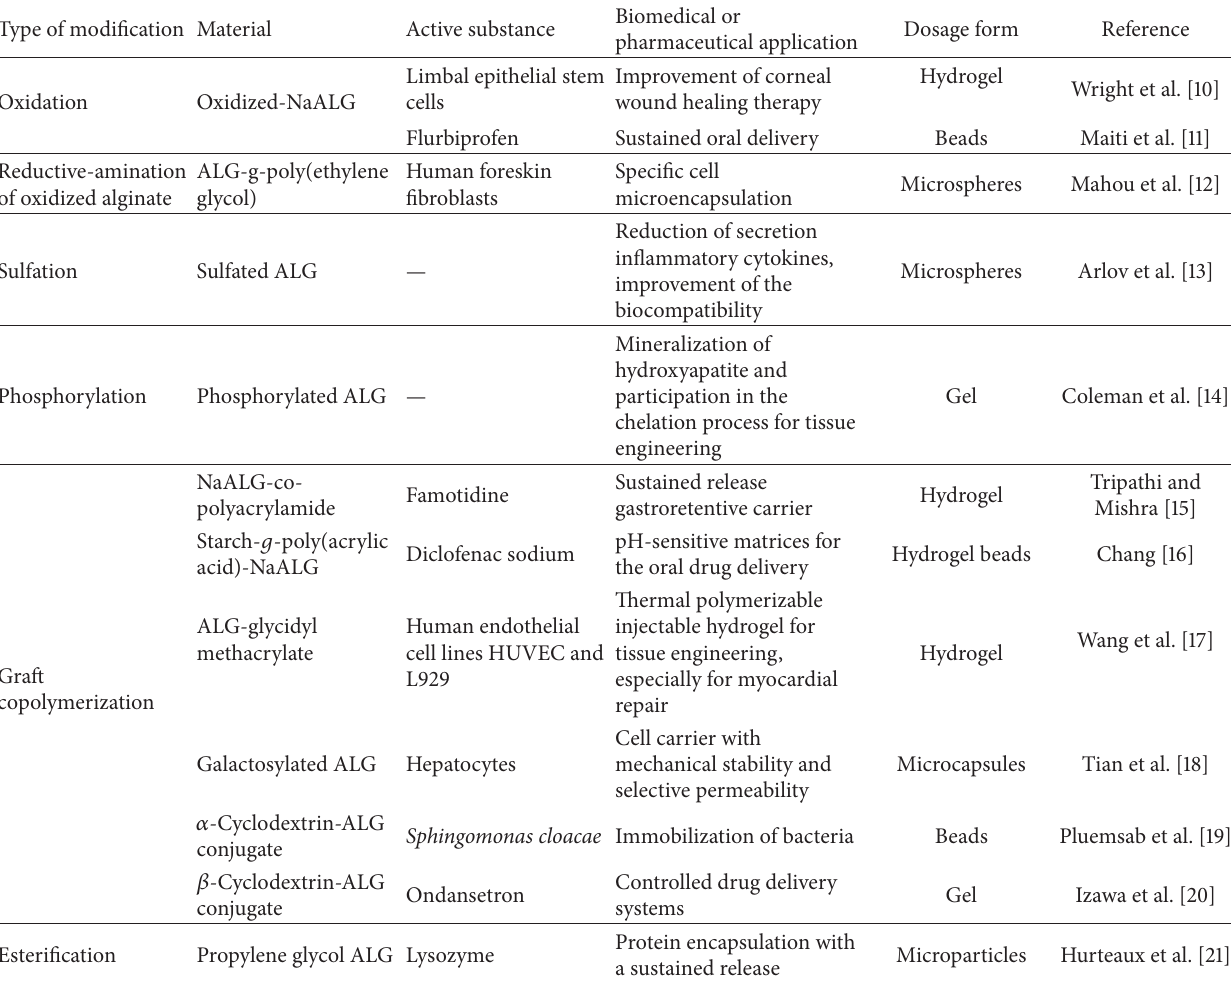
Table 3: Examples of chemically modified-alginate based drug delivery systems and biomedical